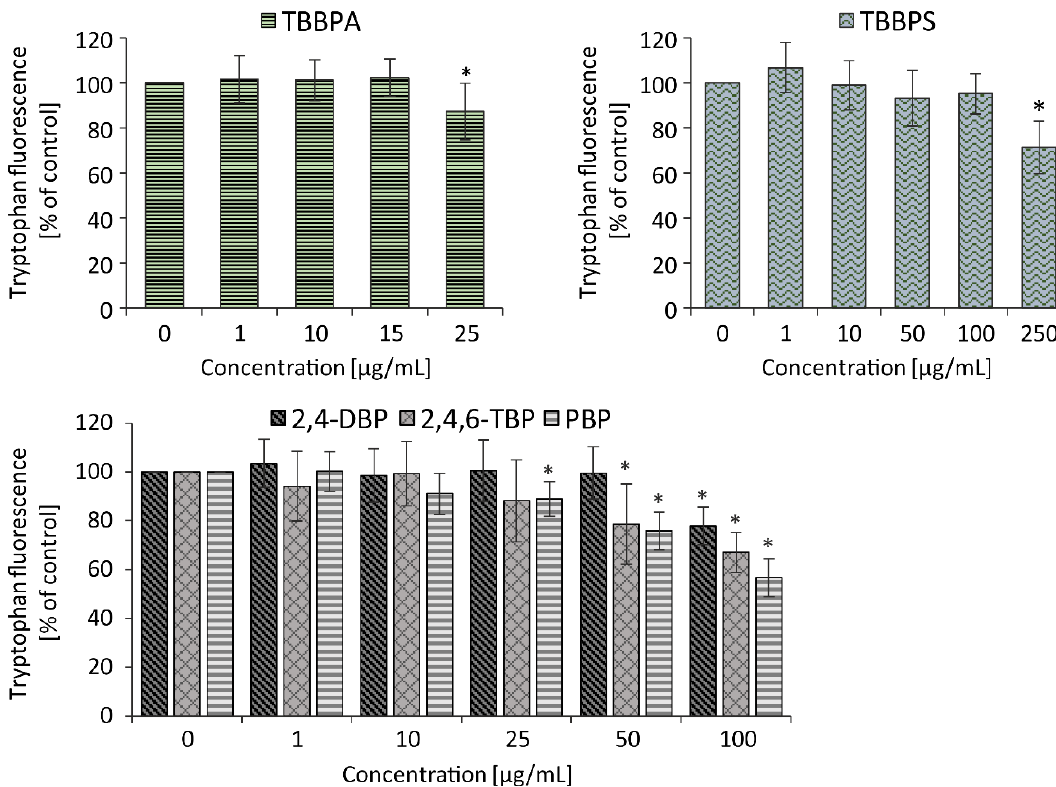
Figure 4. Changes in tryptophan fluorescence (protein damage) in human control red blood cells (RBCs) and the RBCs incubated with TBBPA, TBBPS, 2,4-DBP, 2,4,6-TBP and PBP at the and the RBCs incubated with TBBPA, TBBPS, 2,4-DBP, 2,4,6-TBP and PBP at the concentrations ranging concentrations ranging from 1 to 250 μg/mL for 48 h. (*) Significantly different from control ( p < 0.05); from 1 to 250 µ g / mL for 48 h. (*) Significantly di ff erent from control ( p < 0.05); one-way analysis of one-way analysis of variance (ANOVA) and a posteriori Tukey test. variance (ANOVA) and a posteriori Tukey